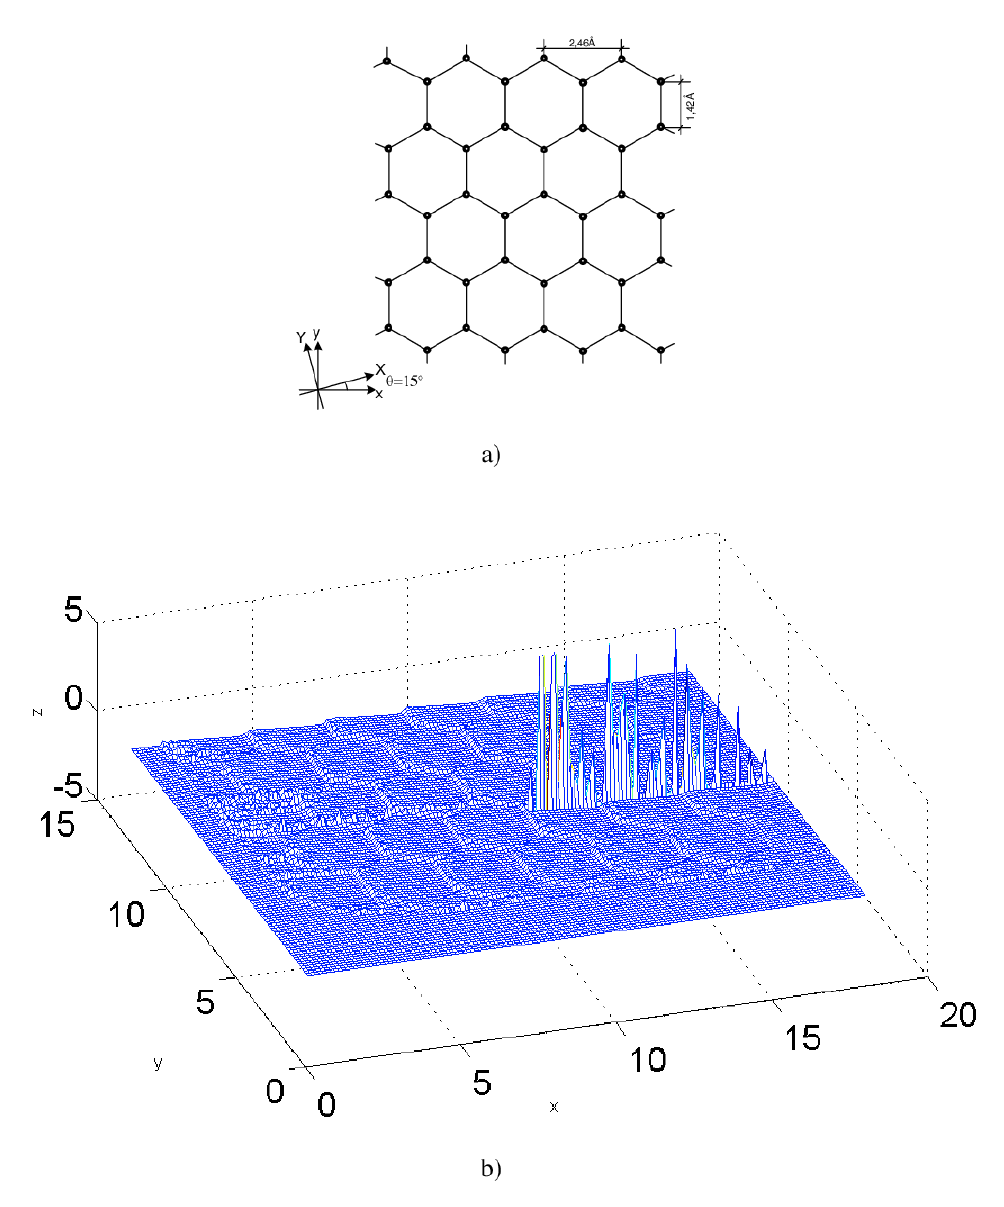
Figure 9 a) Position of the atoms in the HOPG crystal net; b) Elastic force in the tip, F x . used, v (cid:48) , is equal to -0.002788 dr